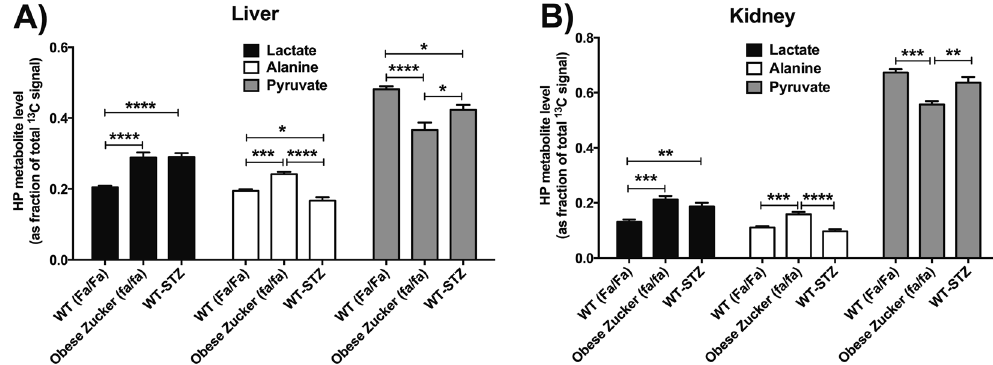
Figure 2. Quantitative summary of the results of localized MR spectroscopy of HP [1- 13 C]pyruvate in liver ( A ) and kidney ( B ) of Zucker rats, grouped by metabolite. Each metabolite / organ group includes results from three experimental groups as described in text: wild type (WT, Fa/Fa , n = 7), diabetic obese Zucker ( fa/fa , n = 6), and diabetic WT-STZ ( Fa/Fa-STZ , n = 6) rats. HP metabolite levels are expressed as a fraction of the total 13 C signal in the corresponding spectrum. Group means are shown with error bars indicating S.E.M. Statistically significant comparisons from one-way ANOVA are labeled ( * p < 0.05, ** p < 0.01, *** p < 0.001, **** p <